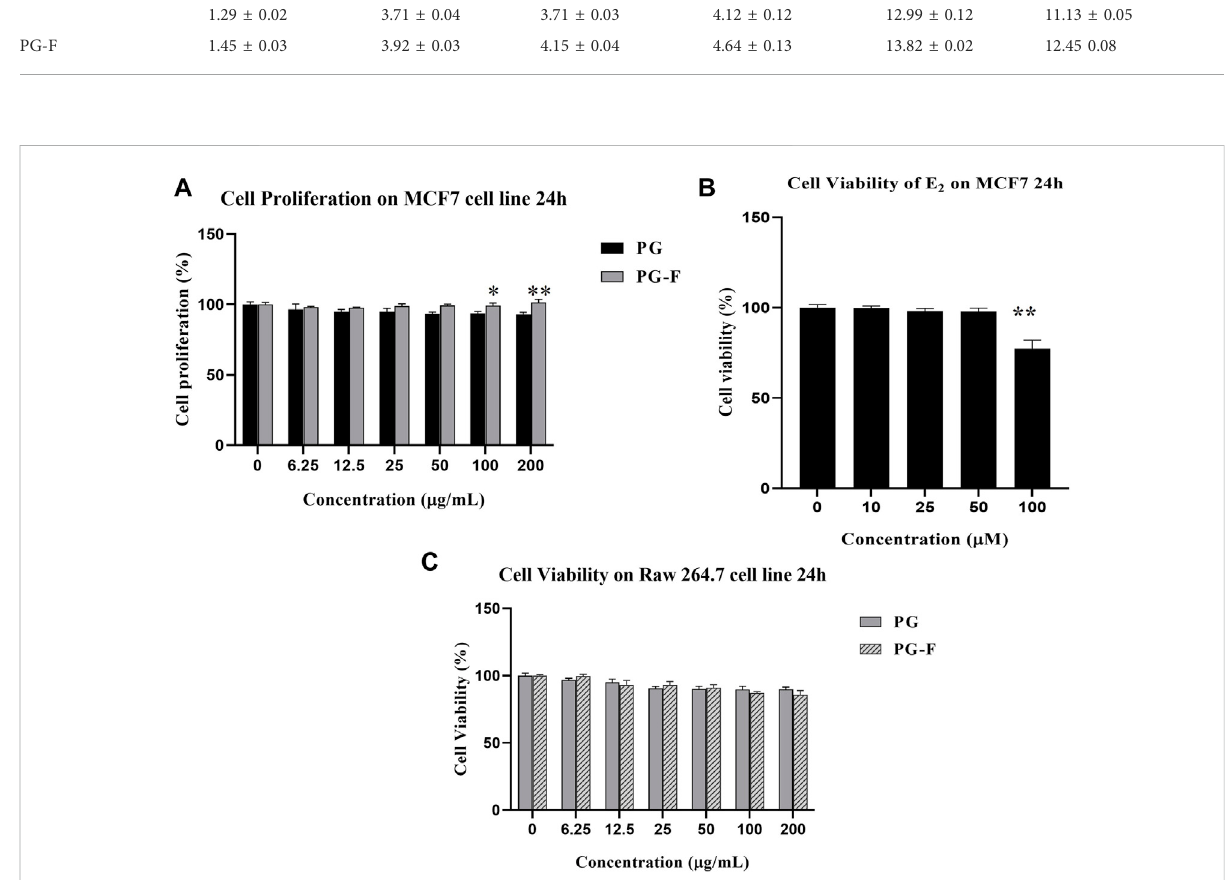
FIGURE 3 Cellproliferationassessment (A) usingMTTinMCF7cells.Thedatashownrepresentthemeanvaluesofthreeexperiments±SD.* p < 0.05,** p < 0.01 as compared with the PG treated group (B) Cell viability of various concentrations of estradiol on MCF7 cells. ** p < 0.01, as compared with the non-treated group. (C) Cell viability measurement of RAW 264.7 cells following the incubation of various concentrations of Pomegranate for 24